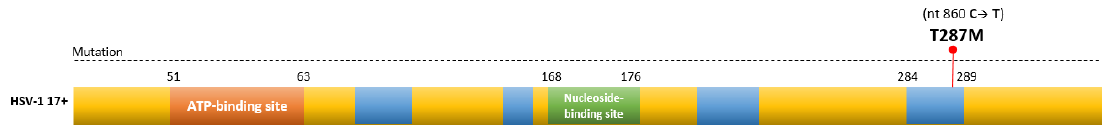
Figure 2. Schematic overview of conserved/active domains of viral thymidine kinase (TK). TK has 6 major conserved regions, an ATP-binding pocket (aa 51–63) composed of glycine-rich loop (red), a nucleoside-binding region (aa 168–177; green), and multiple highly conserved regions (blue), including aa 284–289. The viral TK gene of our ACV R -HSV-1 had a mutation at nt860 (cytosine to thymine), leading to a substitution mutation at aa 287 within the conserved region (threonine to